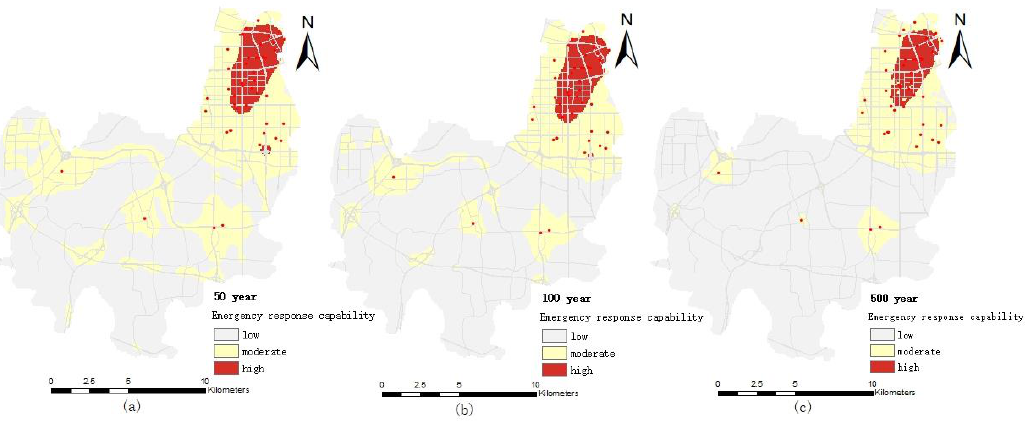
Figure 9. Distribution map of comprehensive emergency response capacity of public service under different pluvial flooding scenarios: ( a ) 50-year pluvial flooding scenario; ( b ) 100-year pluvial flooding scenario; ( c ) 500-year pluvial flooding scenario.